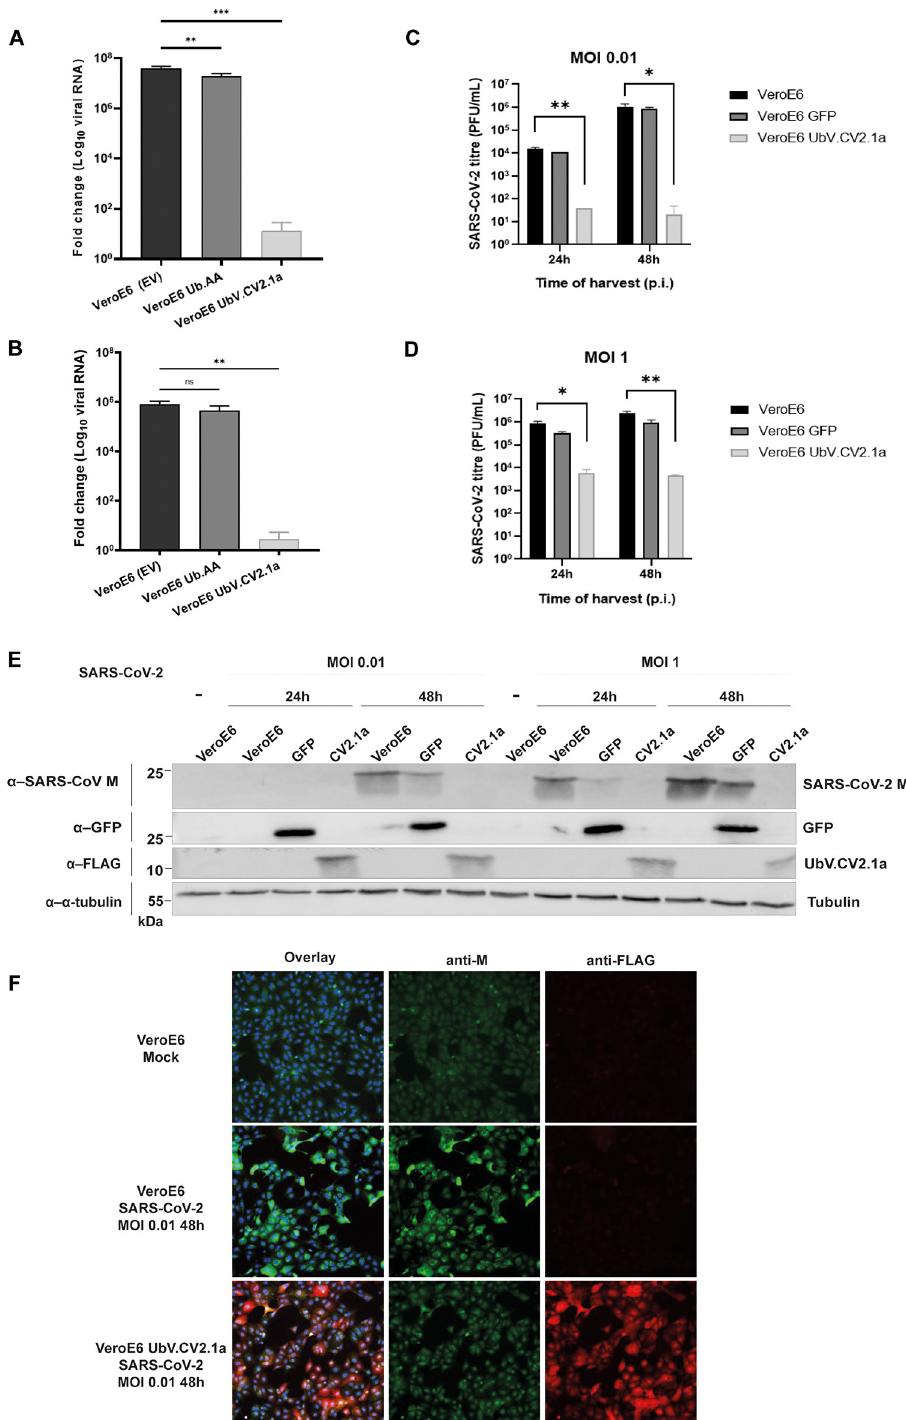
Fig 4. UbV inhibits SARS-CoV-2 replication. (A) SARS-CoV-2 replication was assessed 24 hpi in the presence or absence of UbV.CV2.1a by quantitative RT-PCR using primers specific for the viral N-gene. Stable VeroE6 cells expressing empty vector (black bars) or Ub.AA (dark grey bars) served as controls. UbV.CV2.1a cells are shown in white bars. Data are normalized to β -actin control. (B) A viral propagation assay was performed by using supernatants collected from SARS-CoV-2 infected stable VeroE6 cells to re-infect parental VeroE6 cells and the levels of N gene expression were measured by quantitative RT-PCR as in (A). (C and D) Viral replication was also assessed by